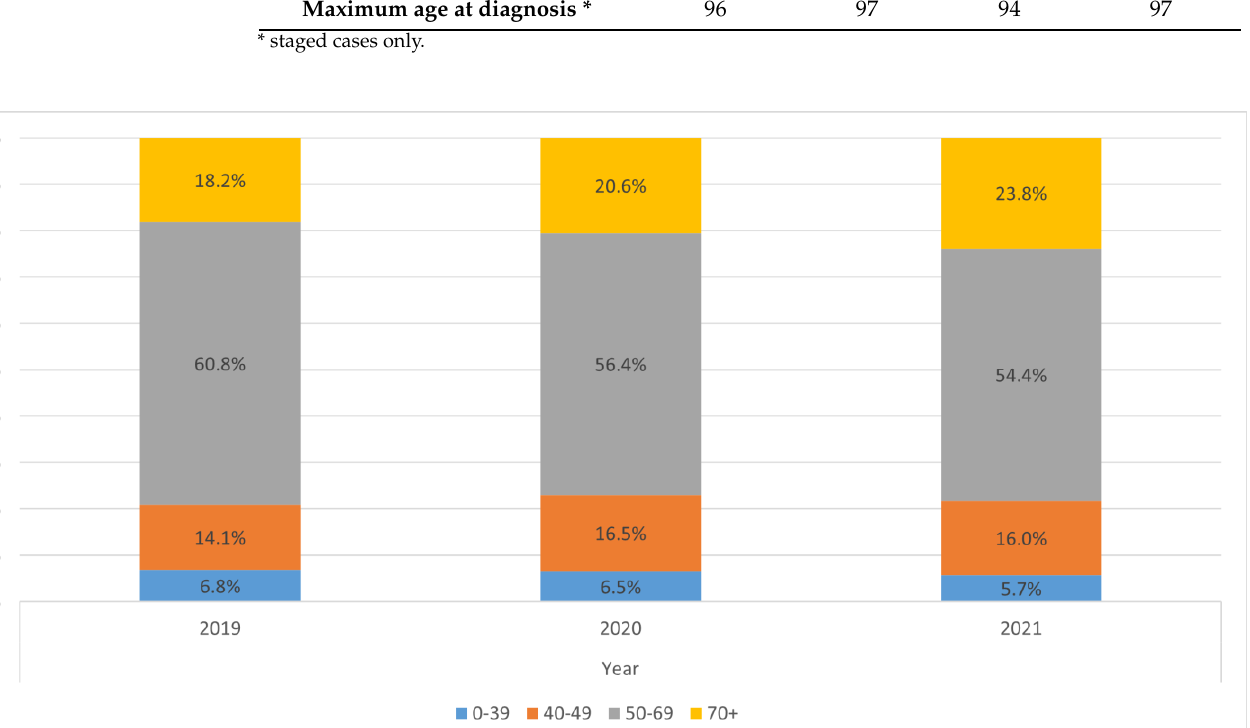
Table 1. Total number of BC cases reviewed by the MDT team in 2019 – 2021.